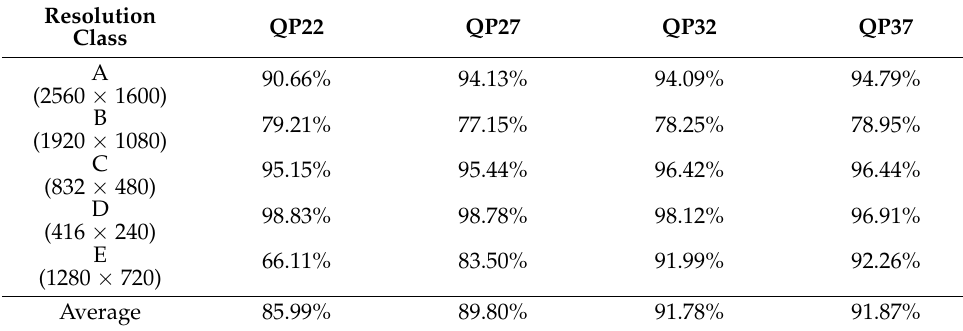
Table 5. Prediction accuracy of different bagged tree models.